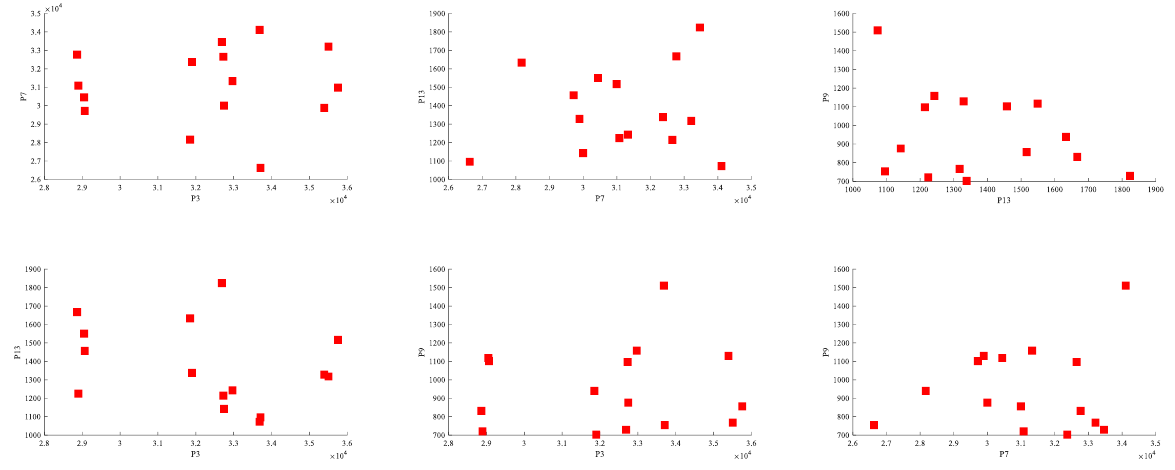
Fig. 8. Sharing sub-space and re-calculating cluster centres.